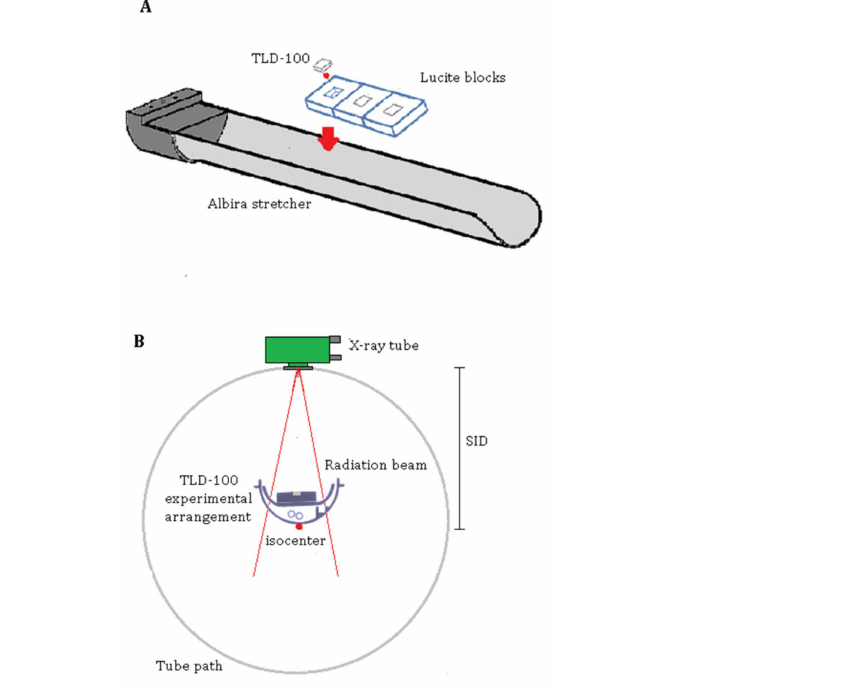
Figure 2. ( A ) The image shows a diagram of the experimental arrangement for surface dose evalua- tion. A set of three acrylic blocks, each with a niche to contain a TLD–100 crystal, was placed on the mouse stretcher of the Albira system. ( B ) The figure shows the circular path of the X-ray tube around the